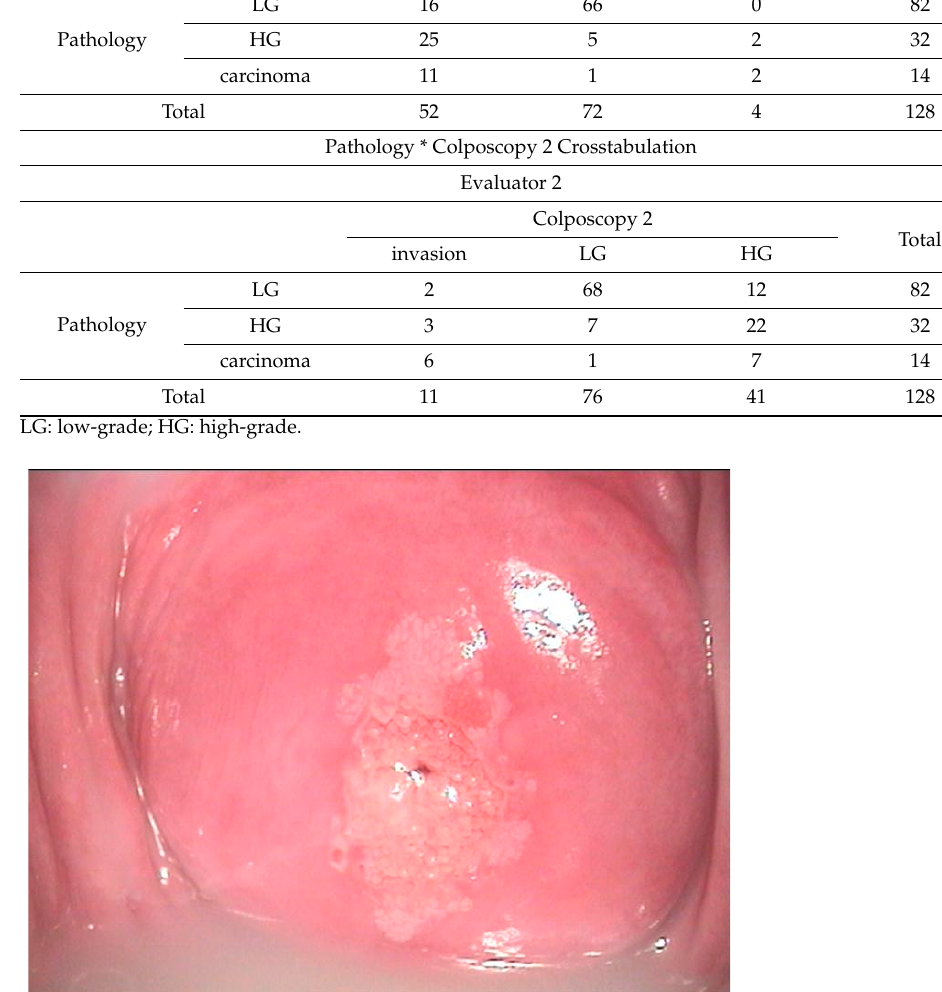
Figure 3. Histologic correspondent of the previous case—LSIL basal and parabasal cell proliferation, superficial epithelial thickening and acanthosis with frequent koilocytes in the intermediary layer (hematoxylin–eosin 10×).